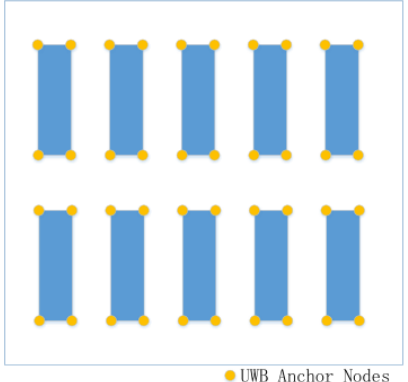
Figure 2. Deployment of UWB anchor nodes.